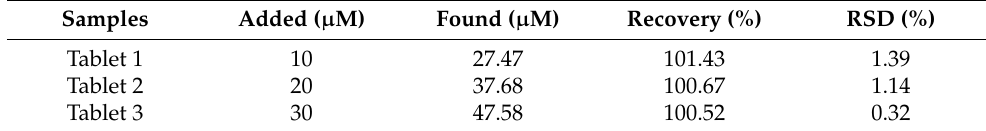
Table 1. Determination and recovery study of AC in actual tablets (n =